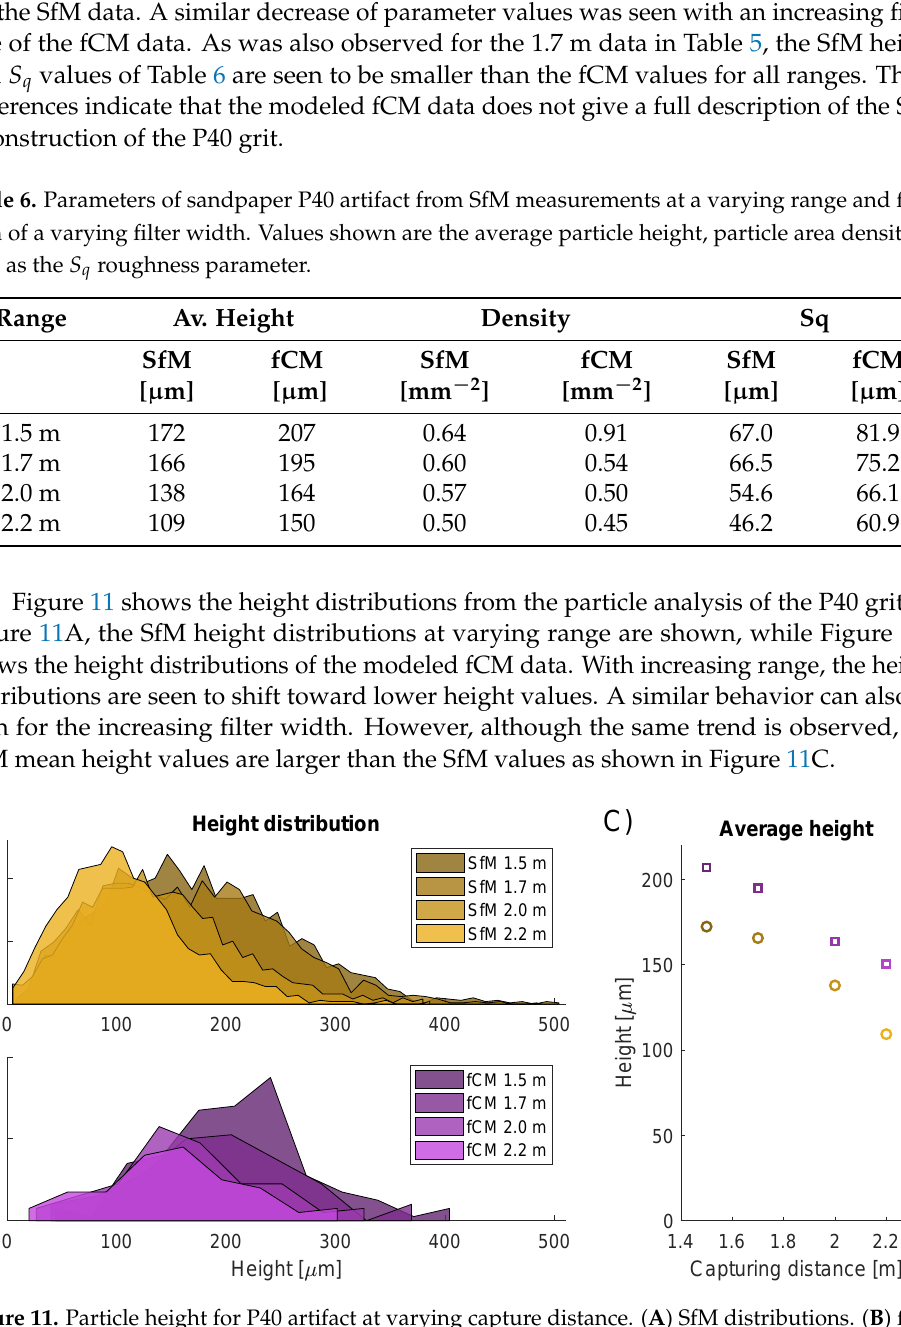
Figure 11. Particle height for P40 artifact at varying capture distance. ( A ) SfM distributions. ( B ) fCM distributions. ( C ) Mean height vs